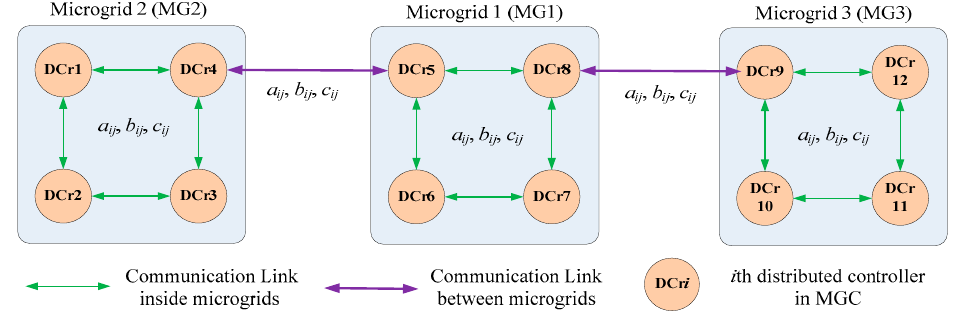
Figure 1. Communication network topology of the microgrid cluster (MGC) under study.